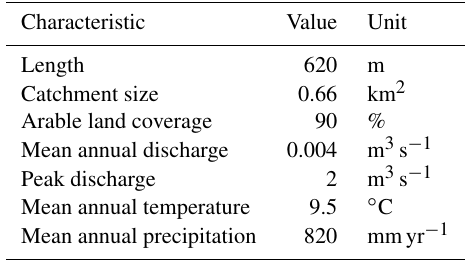
Table 1. Extent and environmental characteristics of the